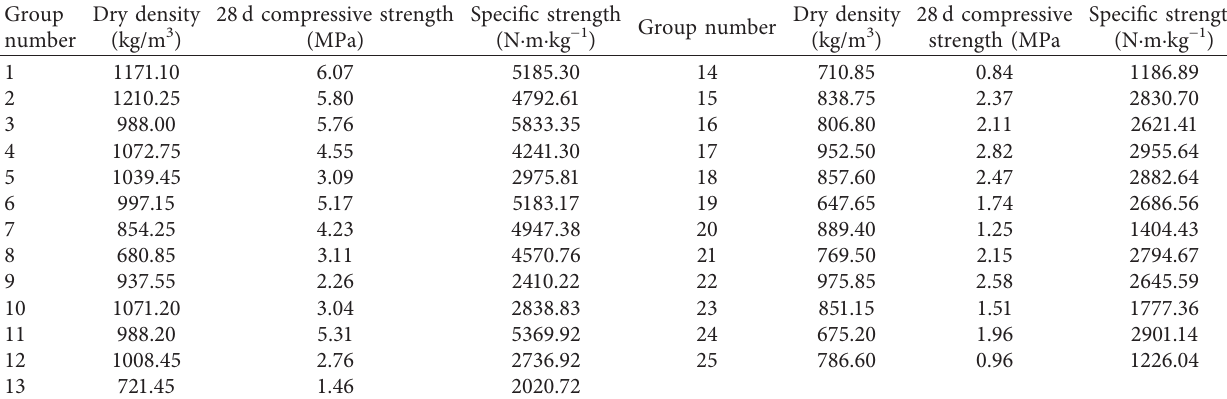
Table 7: Orthogonal test results of recycled brick powder foam concrete.